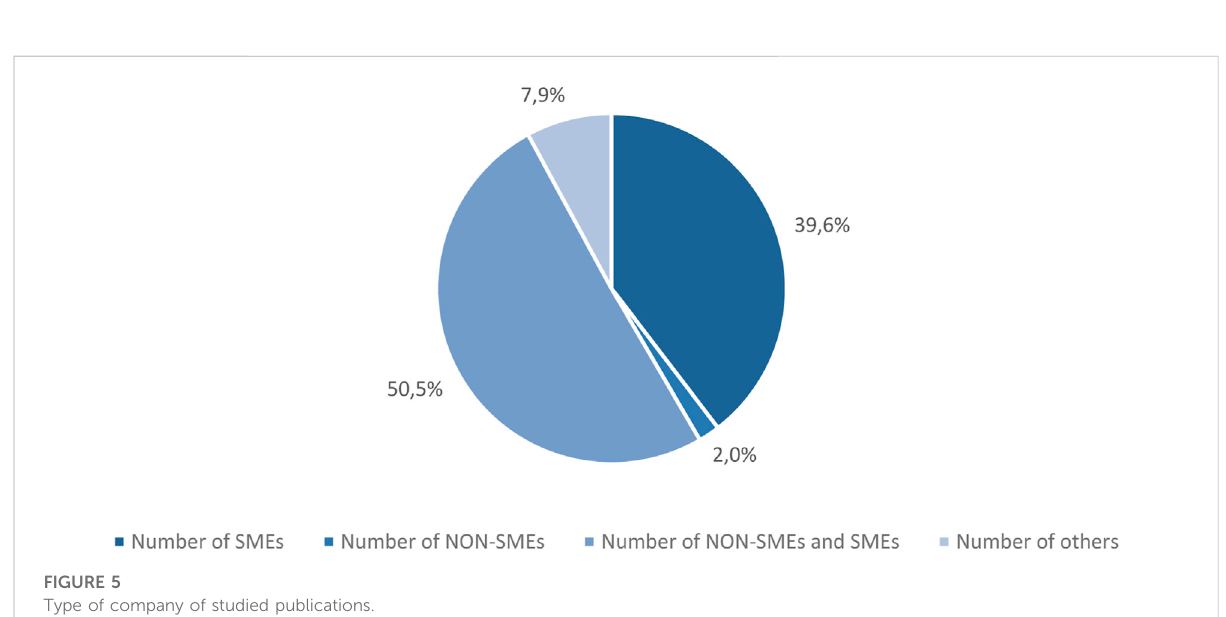
FIGURE 4 Year of studied publications.